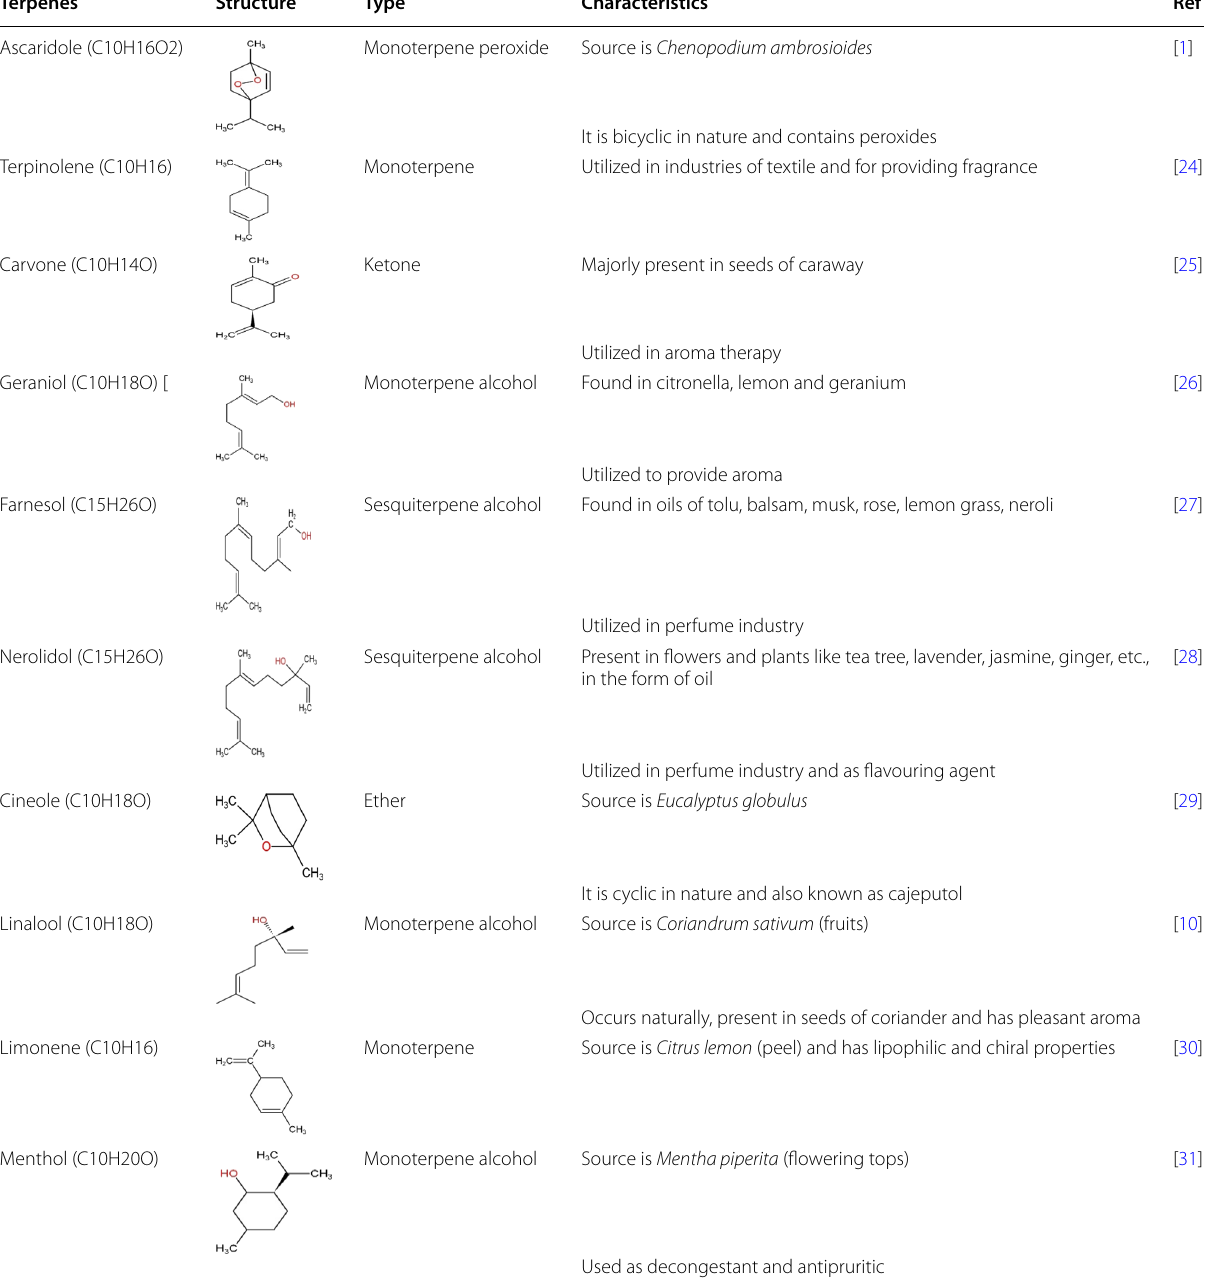
Table 2 Terpenes utilized as permeation enhancer in transdermal systems